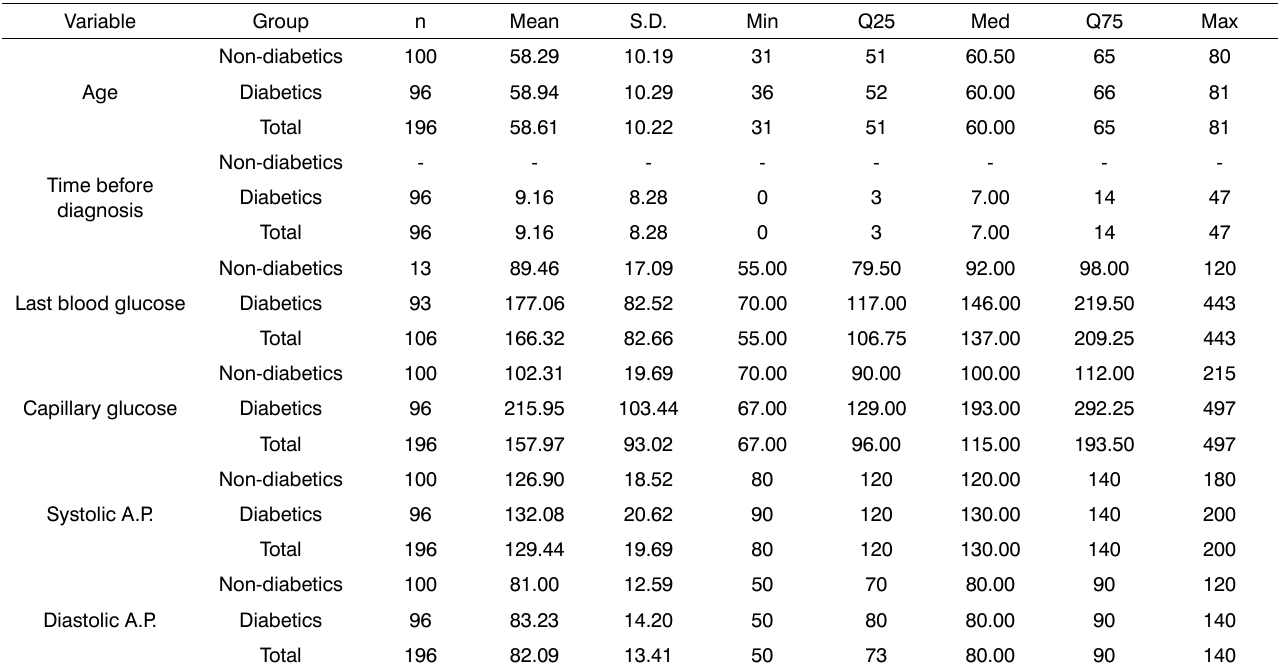
Table 1. Descriptive statistics of quantitative variables in the study sample